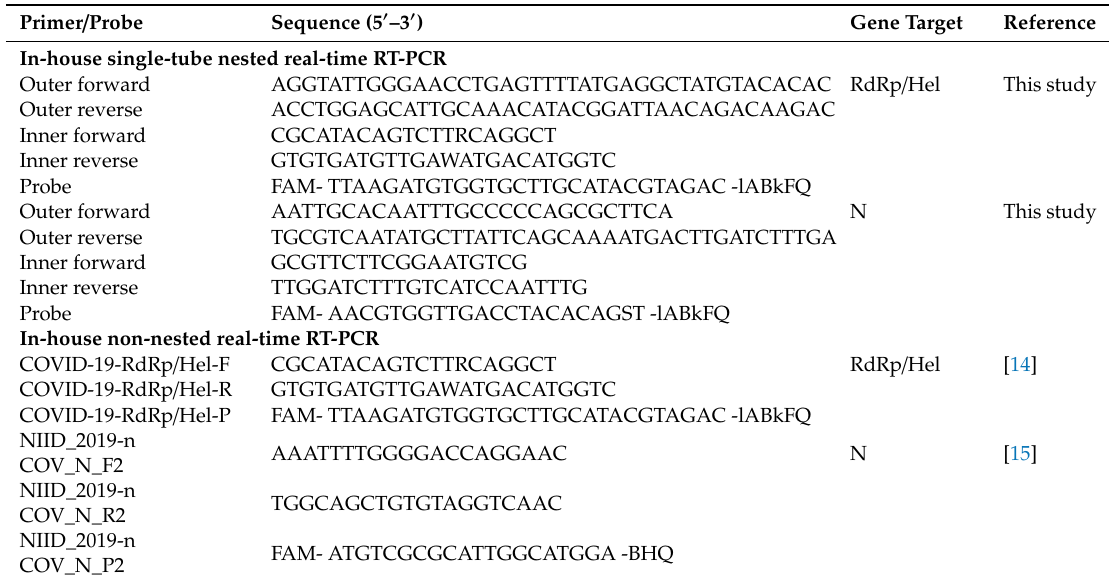
Table 3. Primers and probes used in this